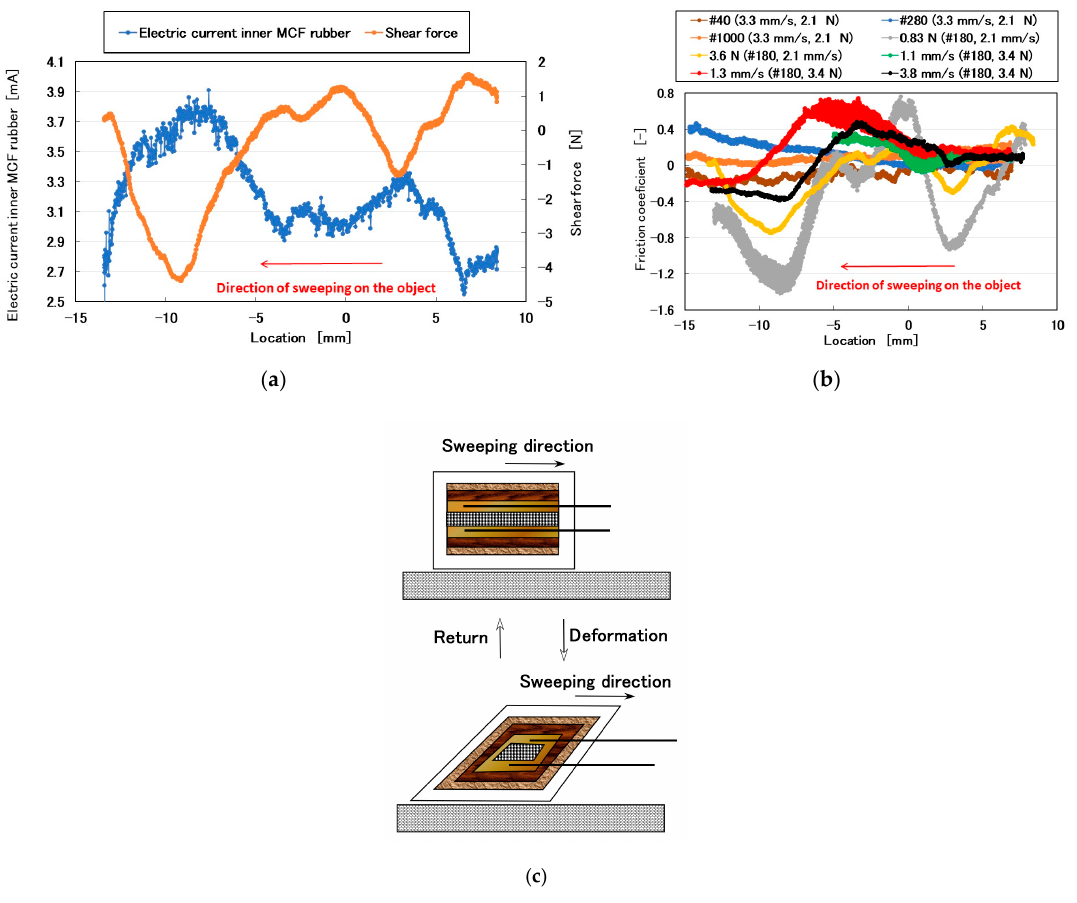
Figure 4. Characteristics of MCF rubber sensor under shear motion; ( a ) corresponding electric current to shear force; ( b ) friction coefficient; ( c ) model of MCF rubber sensor under shear motion.